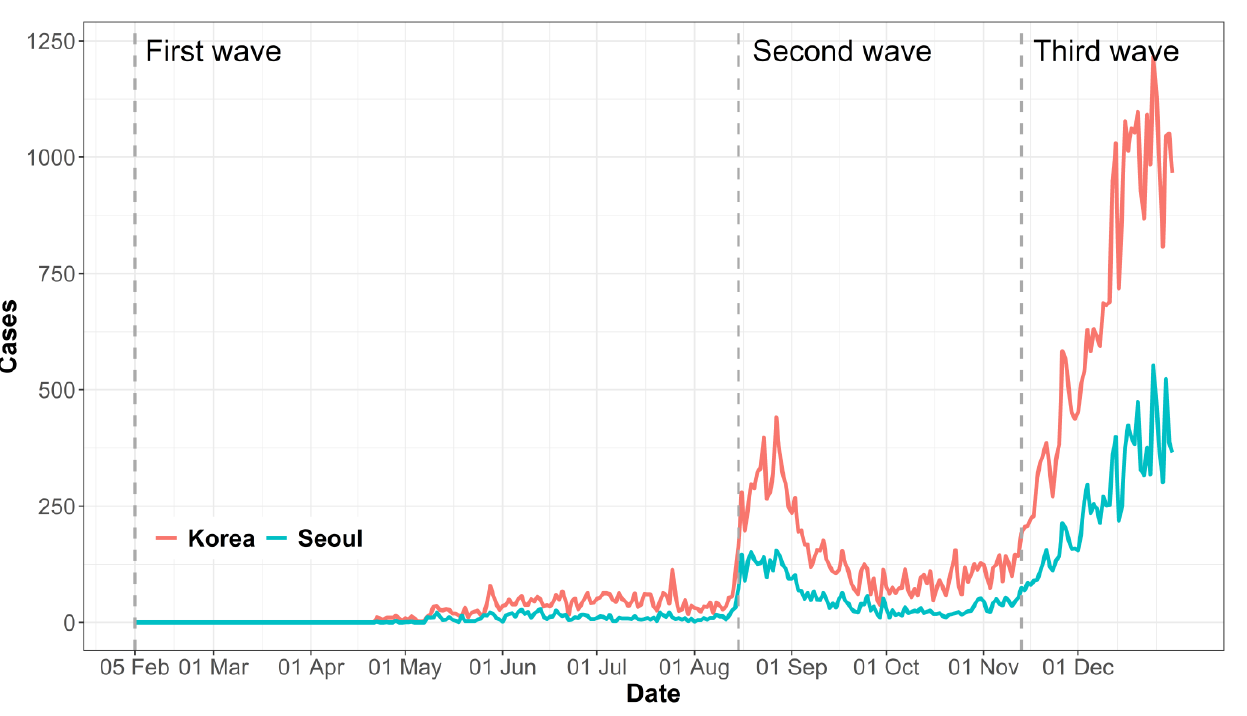
Figure 1. Numbers of newly confirmed COVID-19 cases in 2020.